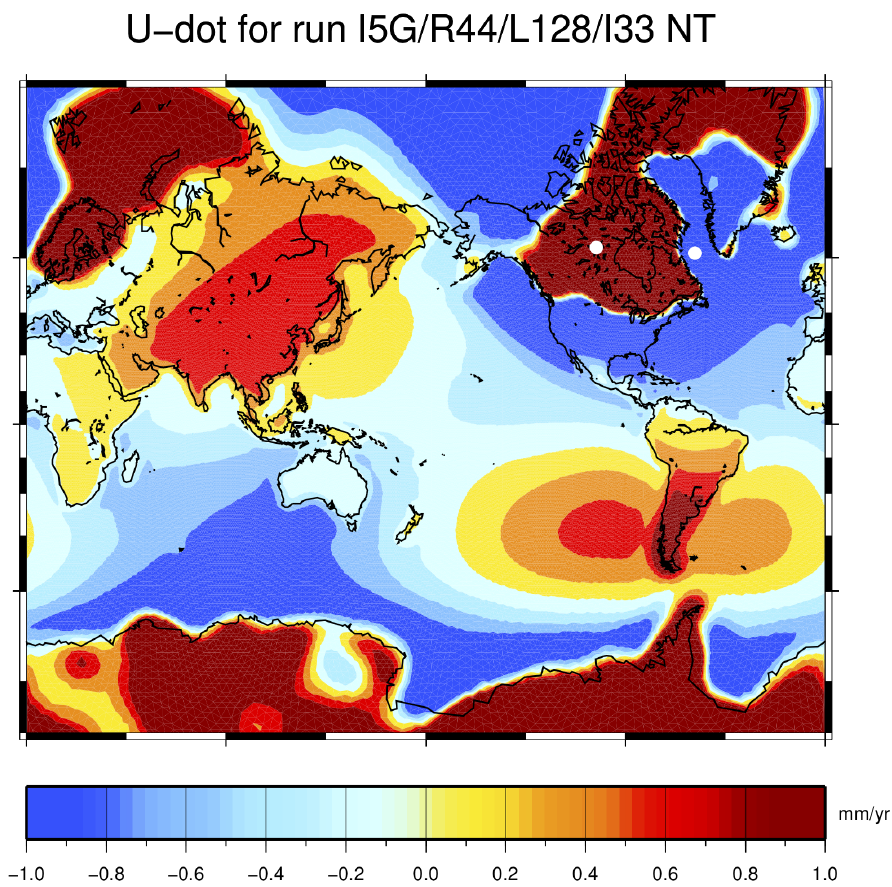
Figure 4. GIA fingerprint for the current rate of crustal uplift ˙ , according to our implementation of U GIA model ICE-5G (VM2). The rates with largest absolute values, marked by white dots, are associated with the melting of the Laurentide ice sheet in north America and Canada, and are found in the same + 19.2 and ˙ locations of Figure 3, with values of ˙ 5.7 mm year − 1 , respectively. The regional U ∼ U ∼ − variability of the ˙ fingerprint appears to be comparable to that of ˙ in Figure 3 but the rotational lobes U S are much more